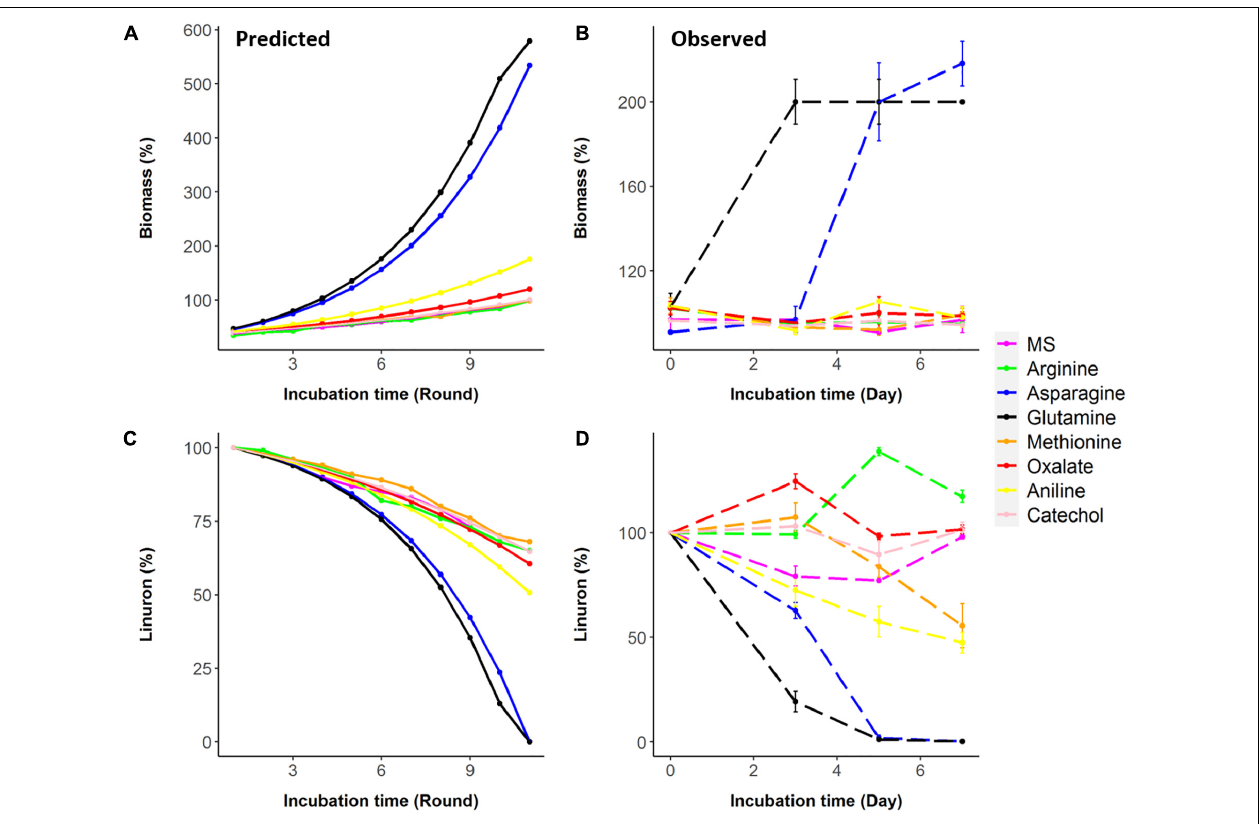
FIGURE 5 | Predictions (based on Pathways 2 and 3) vs. observations for biomass and linuron degradation by Variovorax SRS 16. (A,B) Biomass predicted and observed. (C,D) Linuron degradation predicted and